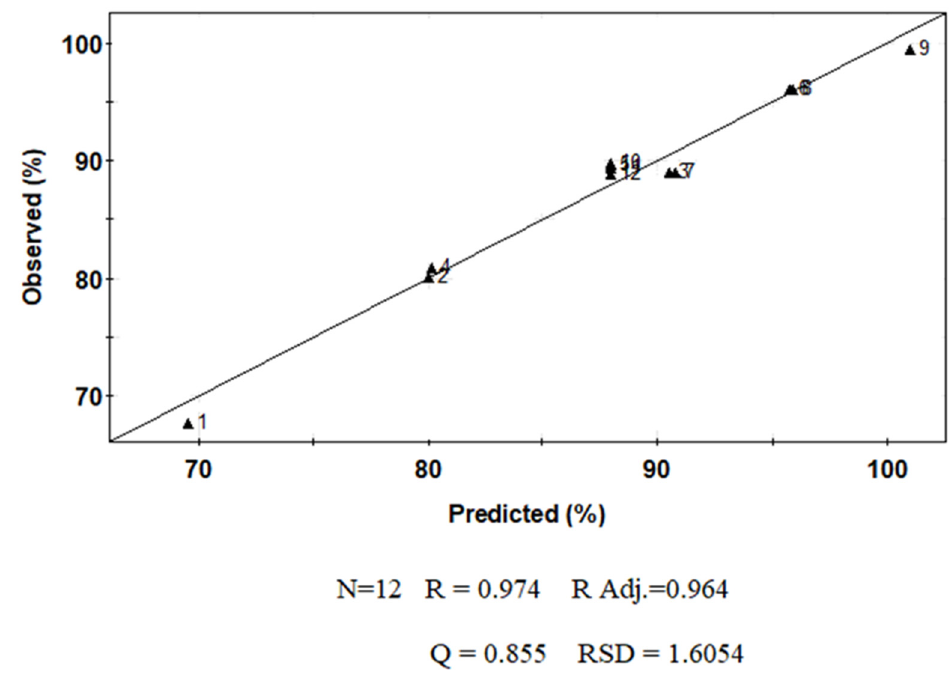
Figure 4. Observed versus predicted values of the response given by the experimental design for the bioremediation process optimization in the function of the variables pH and treatment time with the bacteria forming biofilms.